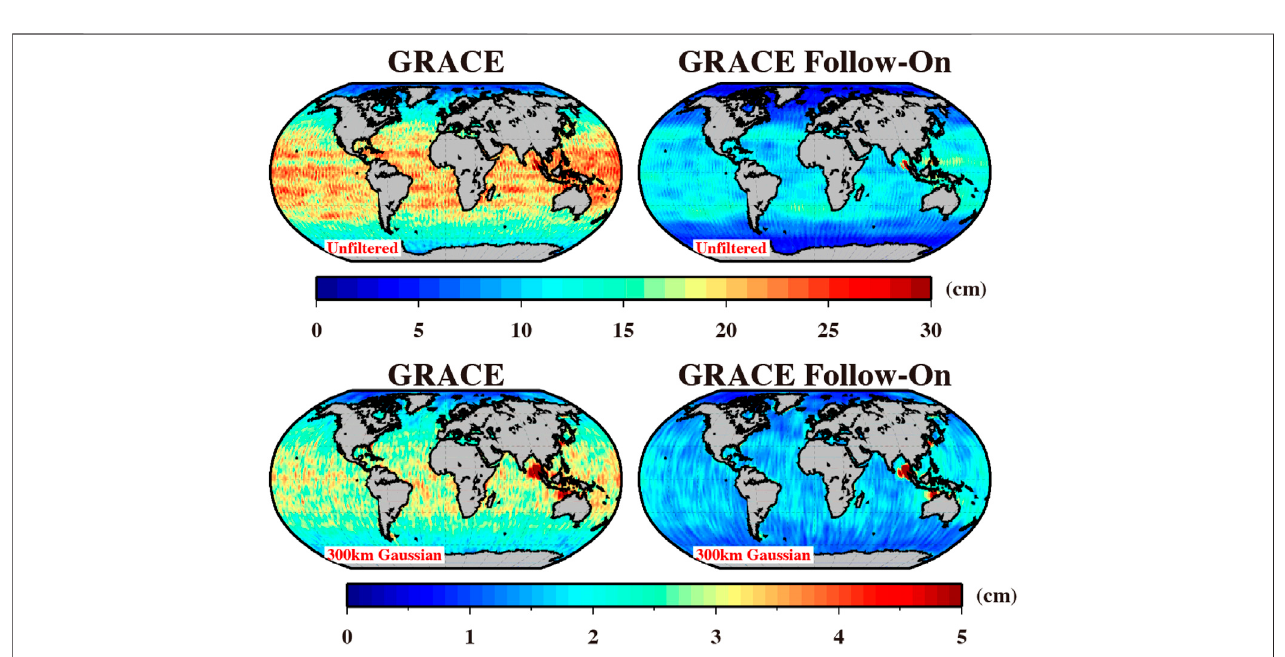
FIGURE 13 | RMS residuals of simulated GRACE and GRACE Follow-On mission. Both un fi ltered and 300 km Gaussian fi ltered solutions are displayed.